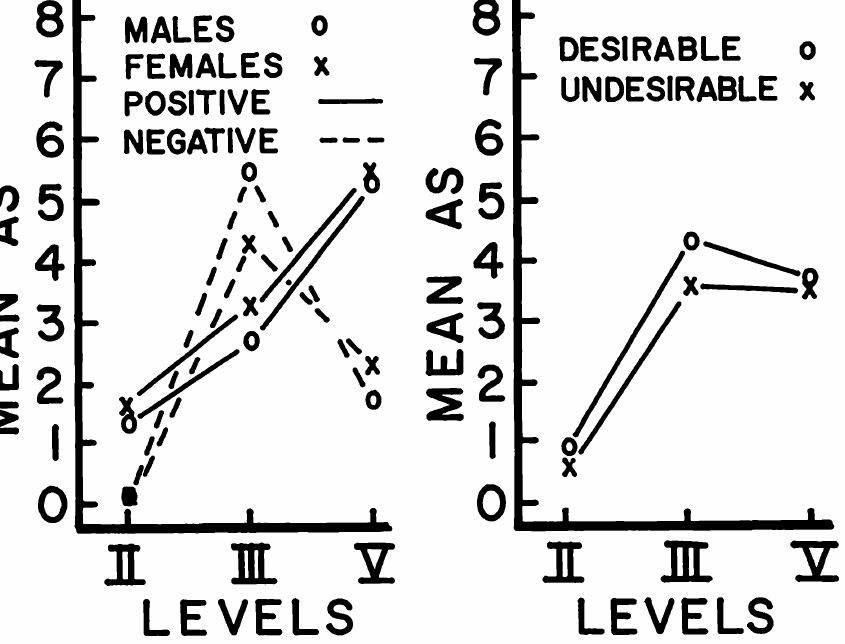
Figure 2.A. Mean assignment of sanction ratings by male and female subjects to positive and negative outcomes at three of Heider's levels. Figure 2.B. Mean assignment of sanction ratings to actors with desirable and undesirable names at three of Heider's